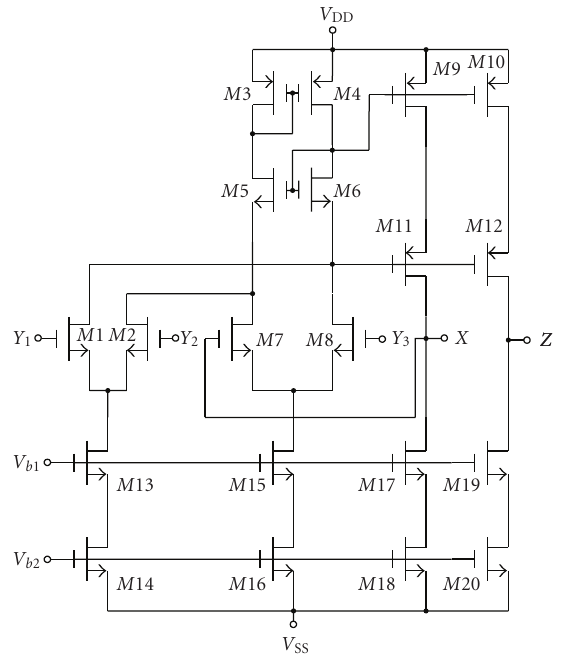
Figure 2: CMOS implementation of the plus-type